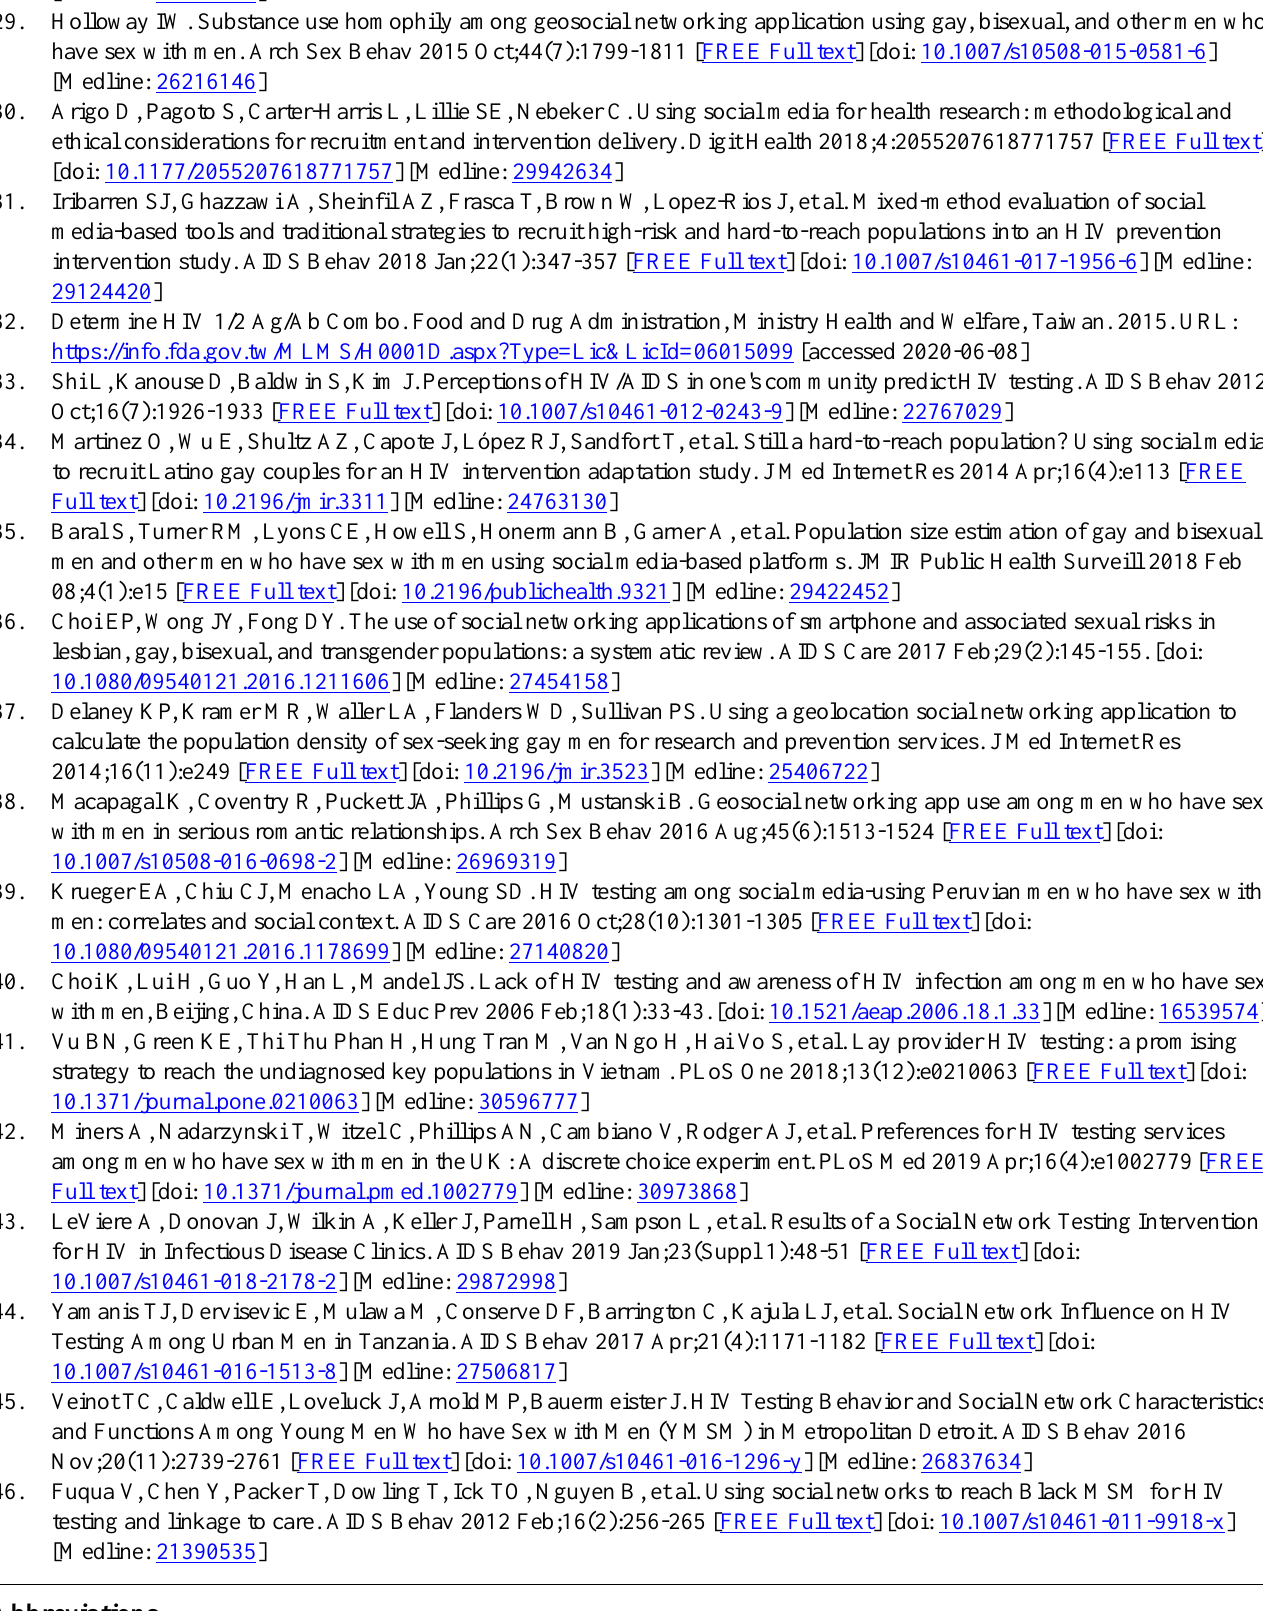
Abbreviations FB: Facebook